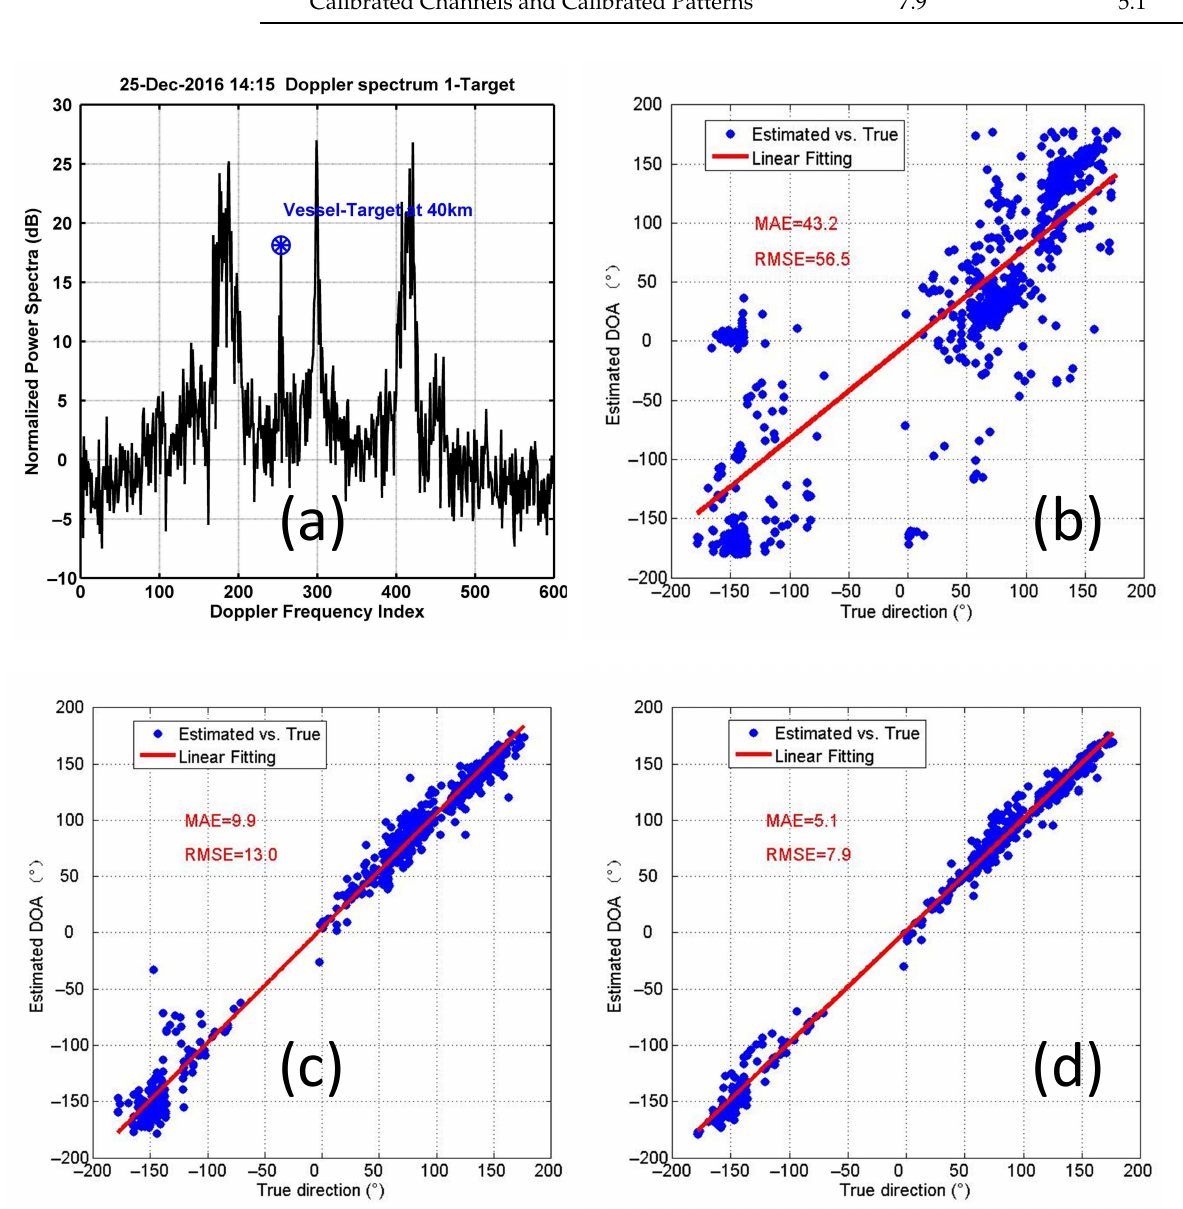
Figure 12. From 1300 UTC+8 25 December 2016 to 1300 UTC+8 26 December 2016: ( a ) an example of a vessel target in the range of 40 km detected by the platform-mounted HF radar and denoted by a blue asterisk embedded in a circle in the Doppler spectrum (Ant. 8); ( b ) estimated 725 vessel-target DOAs (clockwise from true north to the vessel target) compared with the true directions without any calibration; ( c ) estimated 725 vessel-target DOAs after channel calibration; ( d ) estimated 725 vessel-target DOAs after channel calibration and pattern